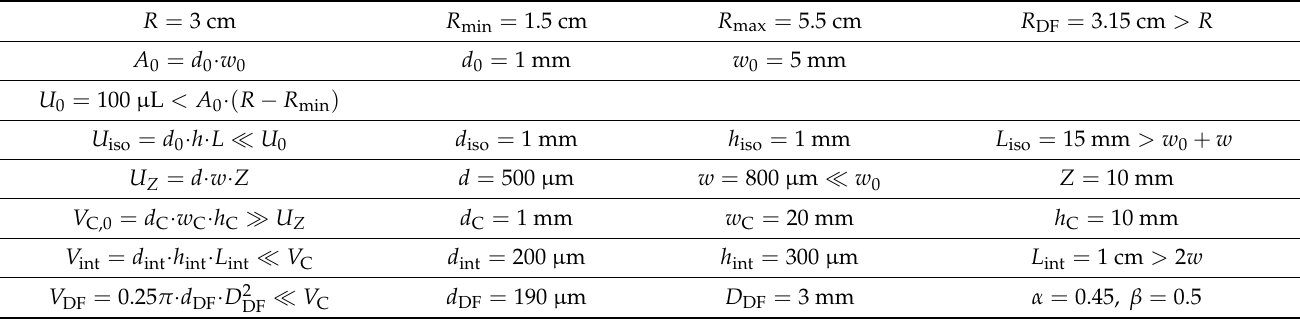
Table A1. Default geometrical parameters and relationships of basic CP-DF siphon valves (Figure 1). The resulting critical spin rate Ω ( R , Γ , U 0 ) /2 π ≈ 25 Hz Minimum lateral dimensions are given by the smallest practical diameter of milling tools (200 µ m). As tools for injection molding are often adopted from optical data storage (e.g., CD, DVD, Blu-ray), a central, 1.5-cm diameter hole and a disc radius of 6 cm with thickness around 1.2 mm, fluidic structures Γ may need to stay within the radial interval between R min = 1.5 cm and R max = 5.5 cm, and an upper limit for the depth of about 1 mm as chosen for the main parts of geometries Γ . For large lateral extensions or small aspect ratios, sagging of the lid, which is often provided by a rather flexible foil, may significantly alter the nominal volume capacity, also in response to the pressure, and might even lead to sticking to the bottom of the cavity. R = 3